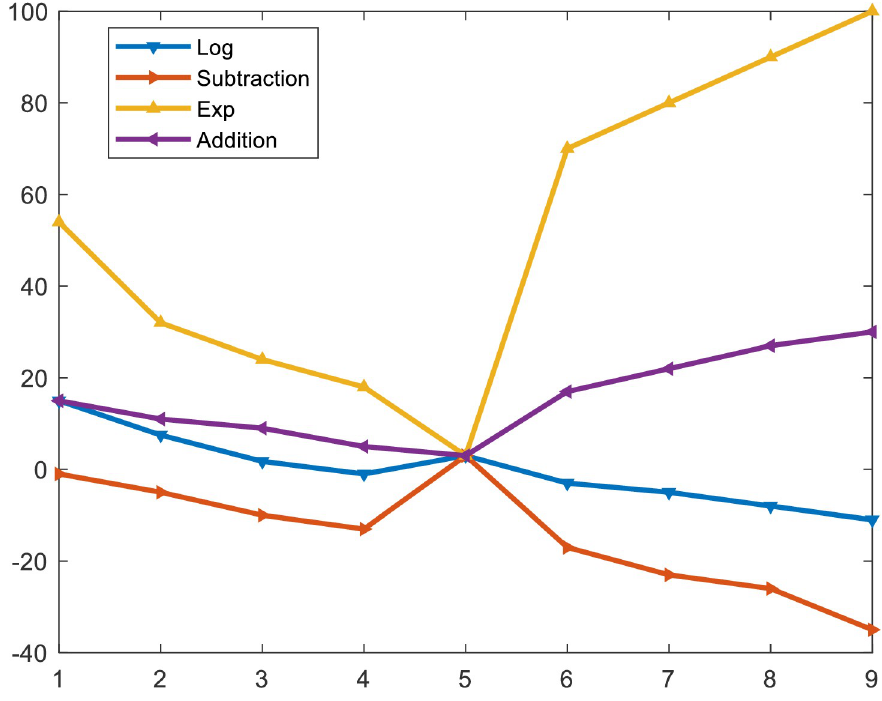
Fig 1. Effect of the optimization